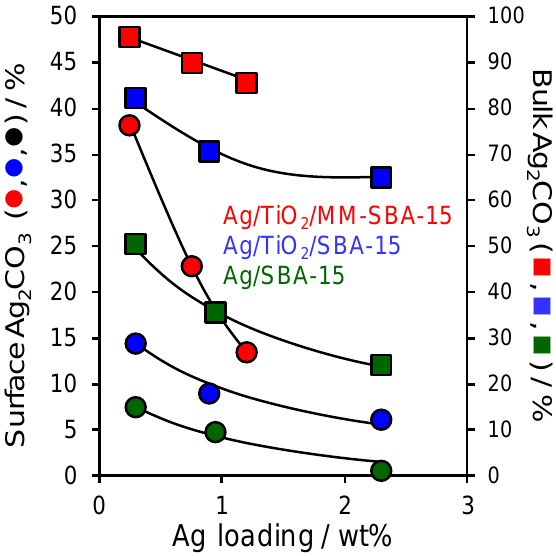
Figure 4. Surface (XPS) and bulk (XANES) silver speciation as Ag 2 CO 3 of Ag/SBA-15, Ag/TiO 2 /SBA-15, and Ag/TiO 2 /MM-SBA-15 as a function of Ag loading.